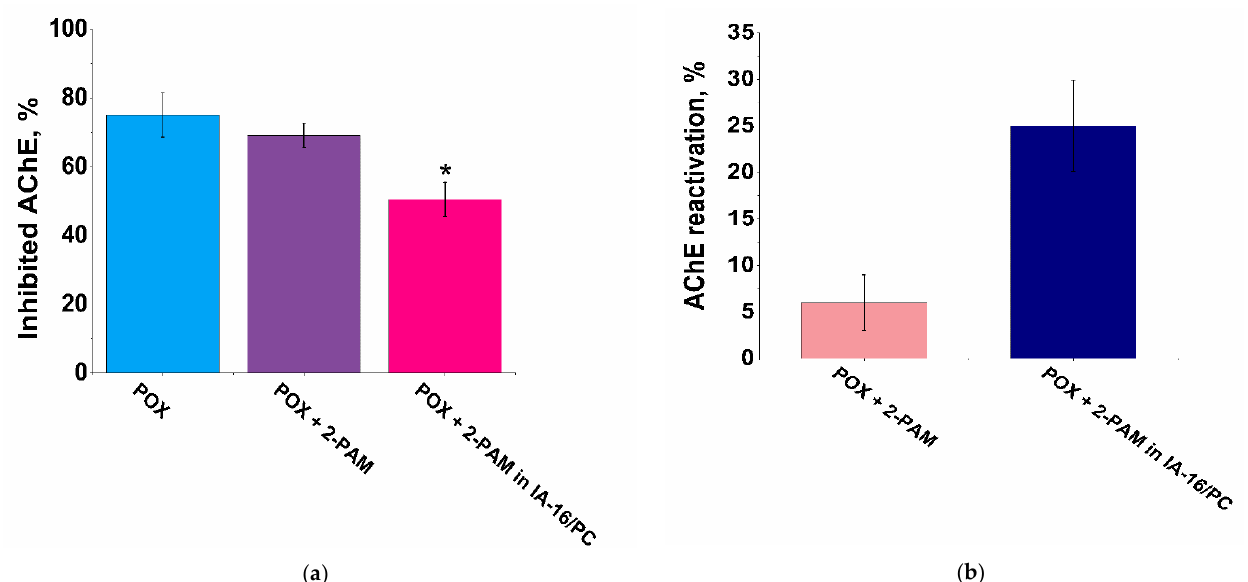
Figure 8. The study of brain AChE inhibition ( a ) and reactivation ( b ) in vivo. Mean AChE activity in brain homogenates was measured in a control group of rats (taken as 100%) after poisoning by POX and after injection of free 2-PAM (dose of 2-PAM was 25 mg/kg) and 2-PAM-loaded IA-16/PC liposomes (dose of 2-PAM was 25 mg/kg). Each point represents the mean percent of AChE inhibition in each experimental group. Data presented as mean ± standard error from 5 brain samples; * indicates significant difference by the Mann – Whitney test ( p < 0.05) compared with the level of brain AChE inhibition detected 1 hour after POX injection.